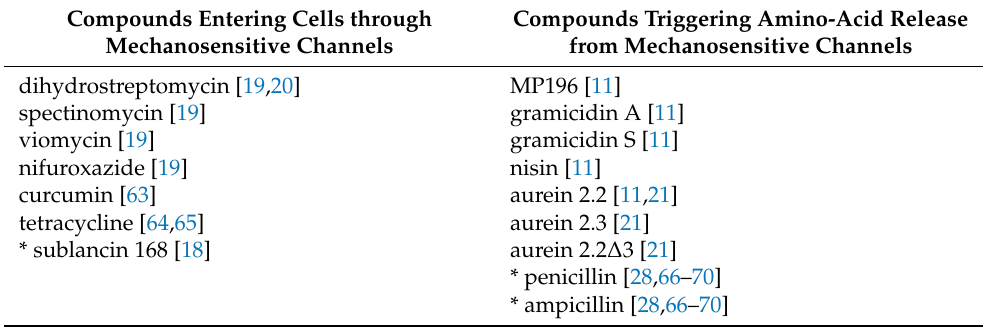
Table 1. Antimicrobials known to be affected by mechanosensitive-channel activity. Compounds Entering Cells